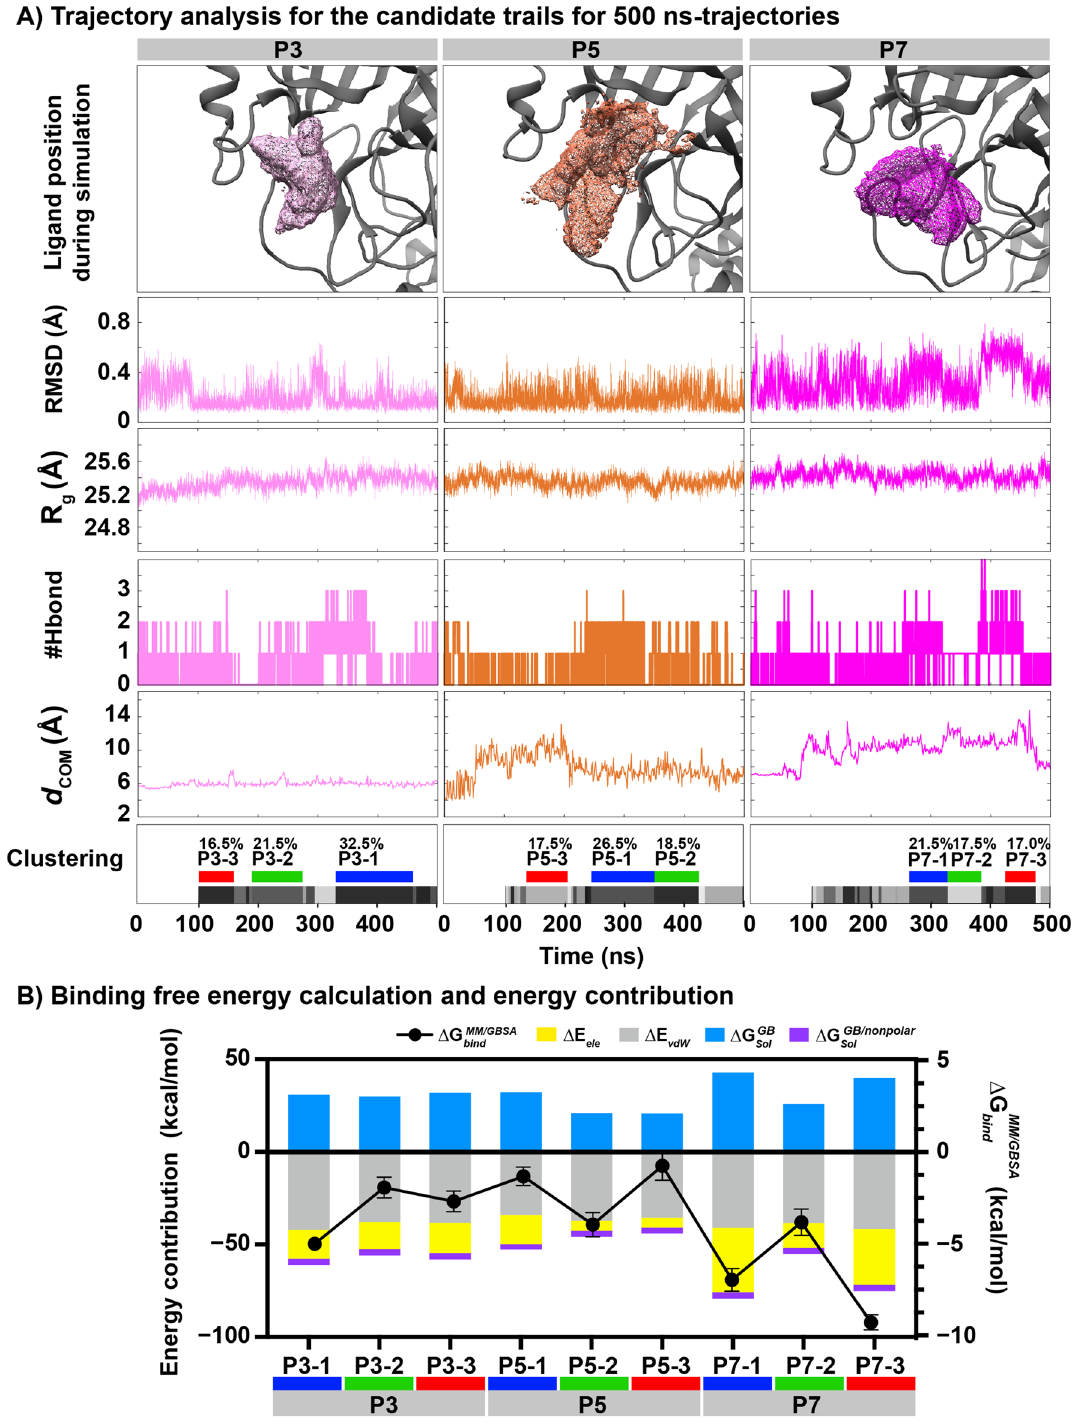
Figure 7. ( A ) RMSD, R g , hydrogen bonding, and d com of rubraxanthone active-site binding plotted as functions of simulation time. Ligand distribution and top three clusters (P3, P5, and P7), as determined from FMO-based RMSD clustering, are shown above and below plots, respectively. ( B ) MM/GBSA-calculated binding free energy MM/GBSA ( (cid:31) G bind ) and energy components for rubraxanthone binding in P3, P5, and P7 clusters are represented by black circles and bar graphs,